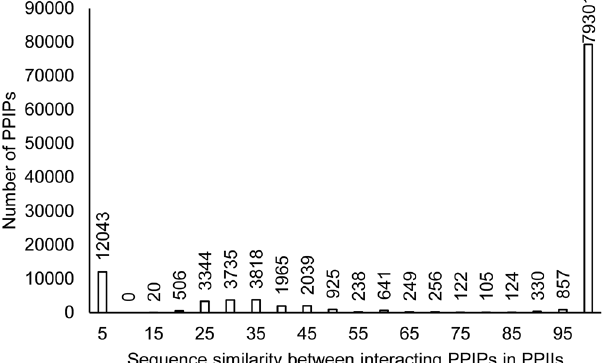
Figure 8. Homo and heterodimeric nature of interacting PPIPs in PPIIs.